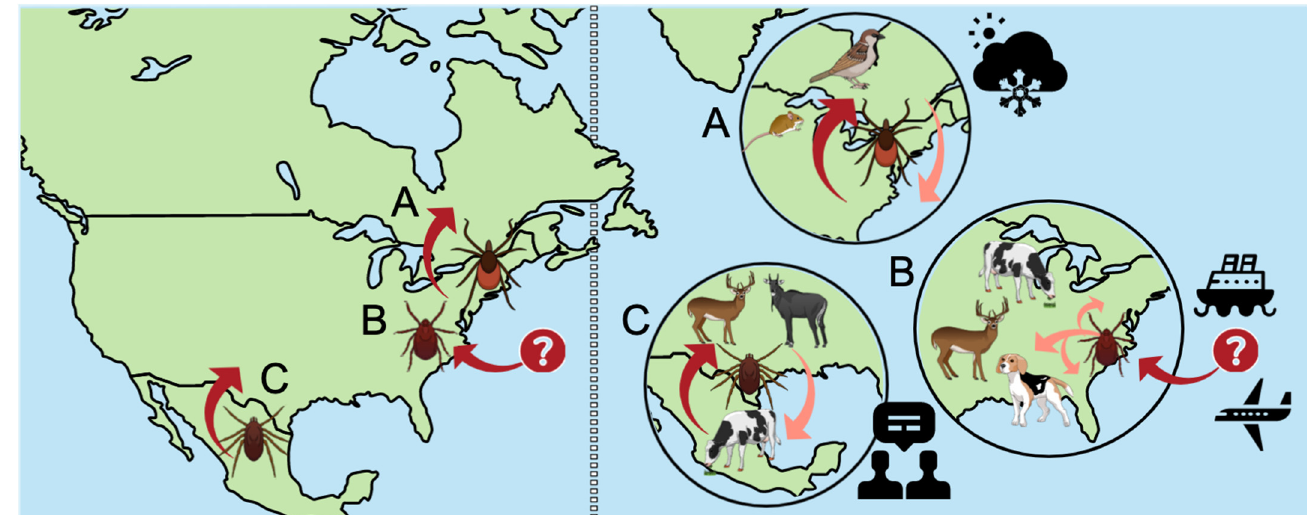
Figure 2. While many challenges remain to tick control, the three identified in this review as the primary challenges in a globalized world are: (A) Global climate change, with a case study of Ixodes scapularis range expansion from the northeastern U.S. into southern Canada, correlated with warmer and milder winters and tick dispersal associated with migratory birds and range expansion of the white-footed mouse; (B) the invasive tick Haemaphysalis longicornis introduction and range expansion in the continental U.S., while the initial introduction is unknown it is likely related to trade and travel with a broad host range facilitating regional dispersal; and (C) political sovereignty and shared geography between bordering countries, highlighted by the collaborations between the U.S. and Mexico at the southern border to reduce movement of cattle fever ticks ( Rhipicephalus spp.) through cattle trade between the bordering countries but complicated by tick dispersal via suitable wildlife hosts (primarily white-tailed deer and nilgai antelop—an introduced species) (figure created in the Mind the Graph platform, www.mindthegraph.com, Cactus Communications.